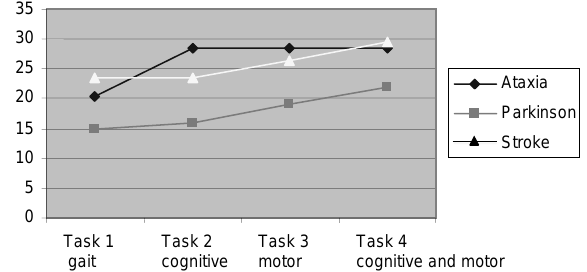
Figure 1 . Median values of the number of steps performed by the Ataxia, Parkinson’s and stroke groups in the four tasks